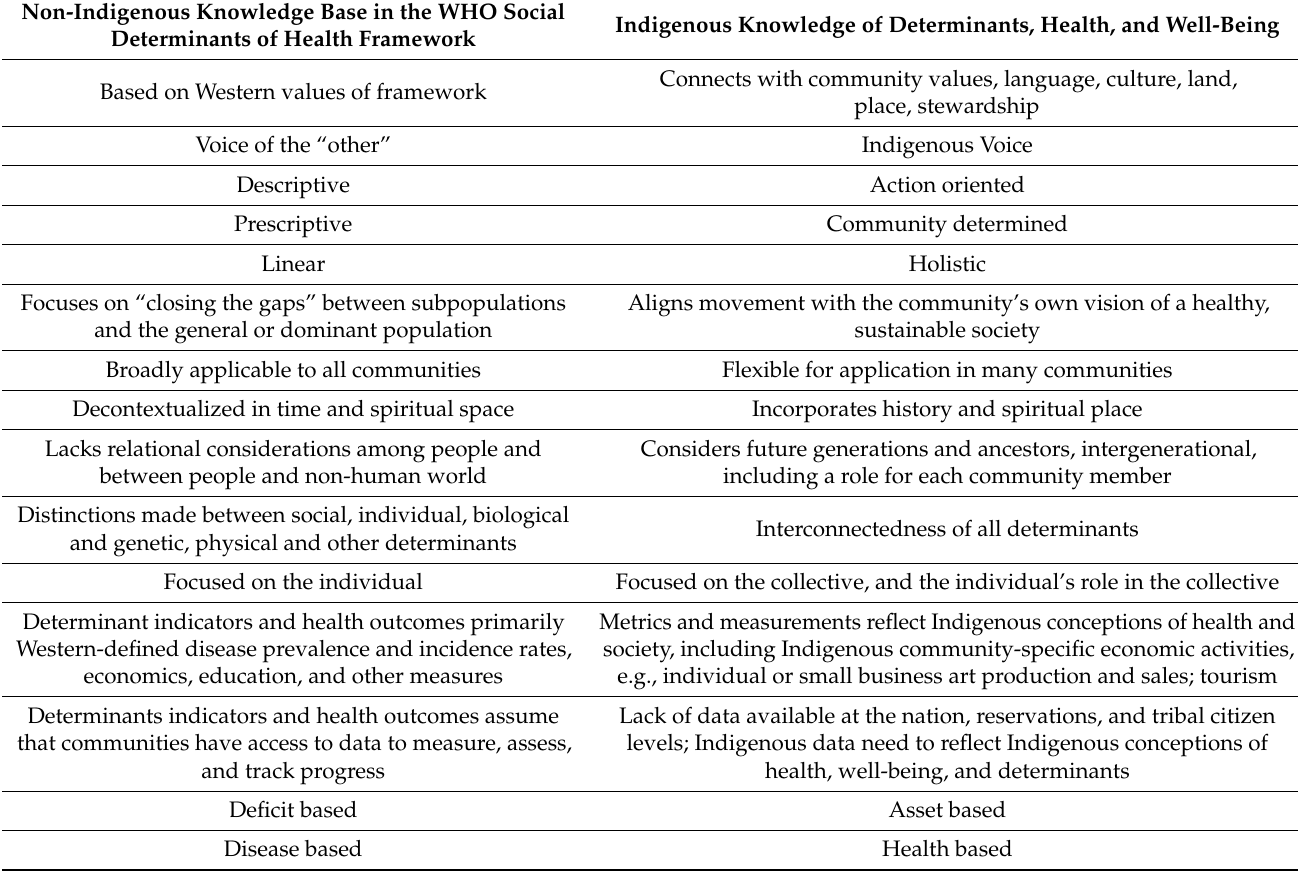
Table 1. Determinants of Health: Indigenous Knowledge and Western World